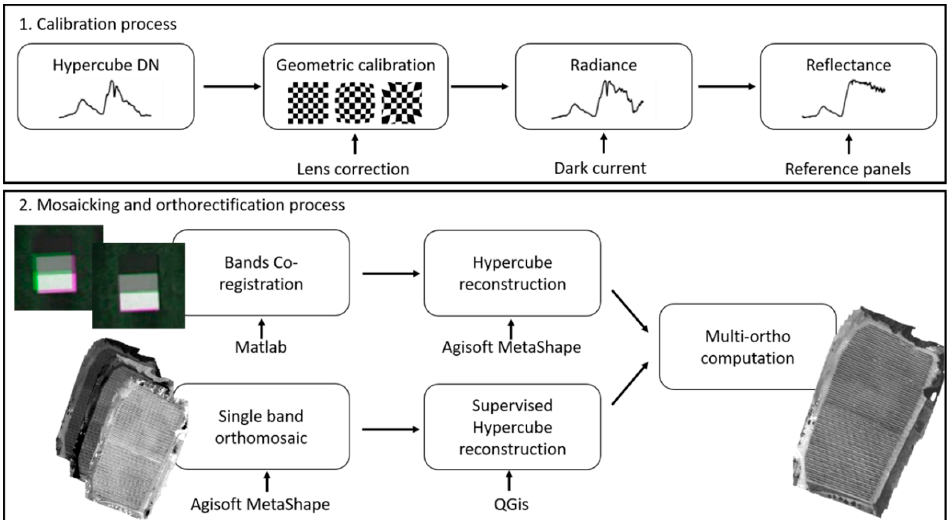
Figure 11. Senop HSC-2 processing workflow.